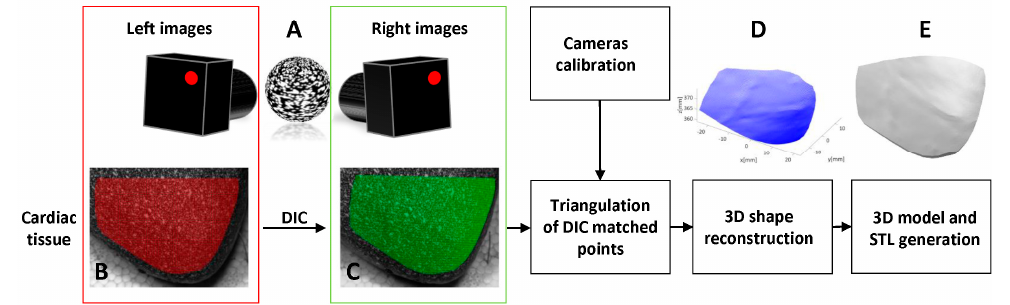
Figure 2. Schematic representation describing the process implemented to reconstruct and generate the 3D model of the cardiac surface using the 3D-DIC technique. ( A ) Stereo-imaging of the cardiac tissue surface (for the sake of clarity, the cardiac sample has been rendered as a sphere); ( B ) Polygonal region of interest (ROI) identified on the image of the cardiac tissue surface (red dots) captured by the left camera; ( C ) The corresponding points (green dots) on the image of the cardiac tissue surface as if it were seen by the right camera computed by the DIC analysis; ( D ) 3D shape reconstruction of the cardiac tissue surface using the cameras calibration data and the triangulation of the corresponding 2D coordinates; ( E ) 3D model and STL generation of the reconstructed cardiac tissue surface.